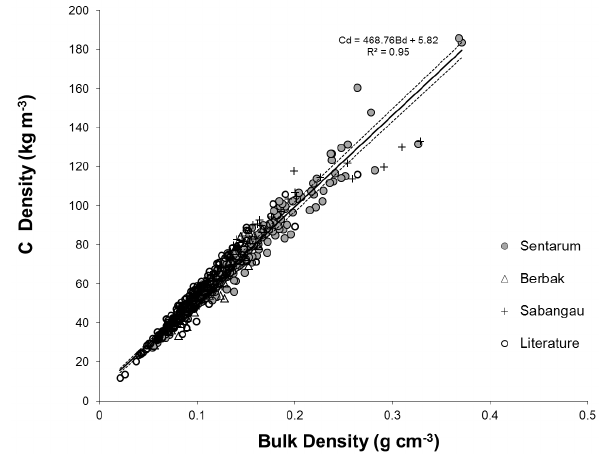
Fig. 2. The linear relationship between peat bulk density and carbon density for 714 data points collected from literature review and three national parks in